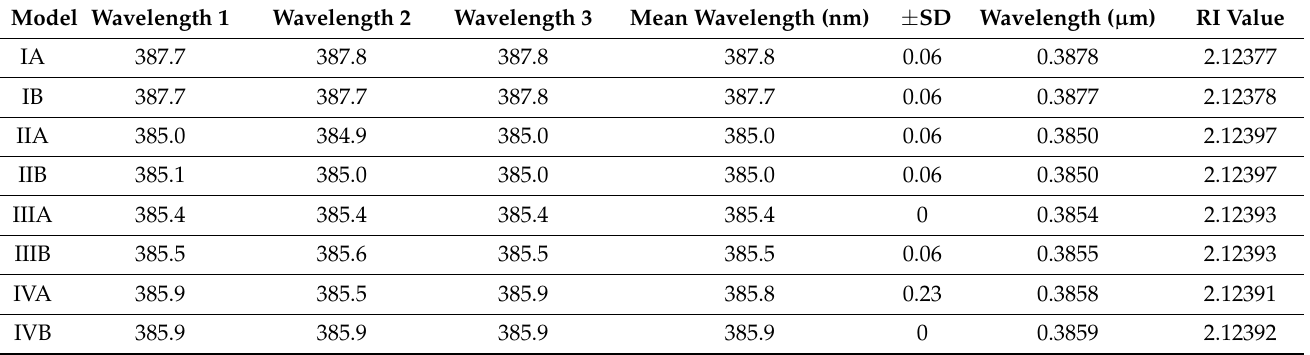
Table 2. The critical wavelengths of all models taken in triplicate and their refractive index (RI) values. Model Wavelength